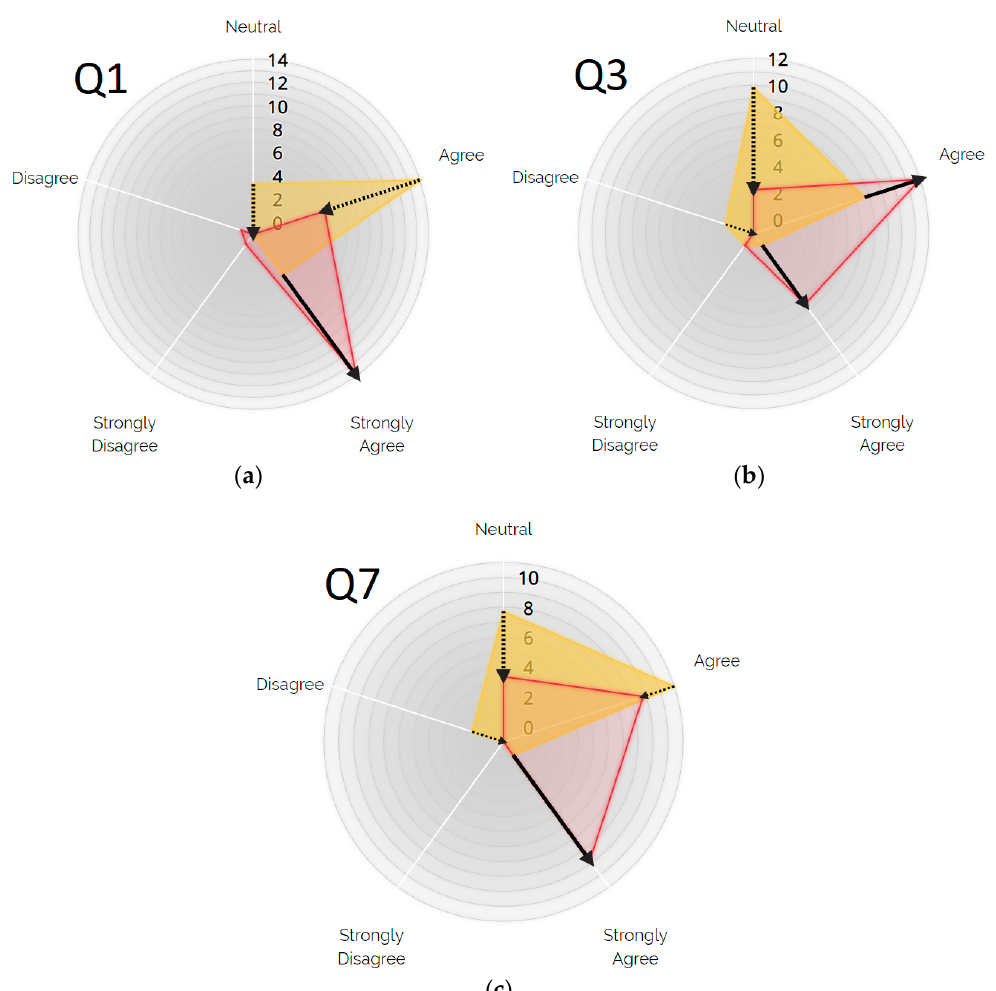
Figure 5. Radar charts showing for all participants, where the changes induced by the games for answers to hypothesis reflects a stronger agreement. Each participant answer ( − 2 = strongly disagree, − 1 = disagree, 0 = neutral, 1 = agree, 2 = strongly agree) is rated on one axis in yellow (pre-game) and red (post-game) areas. The questions answered are ( a ) Q1; ( b ) Q3; ( c ) Q7.